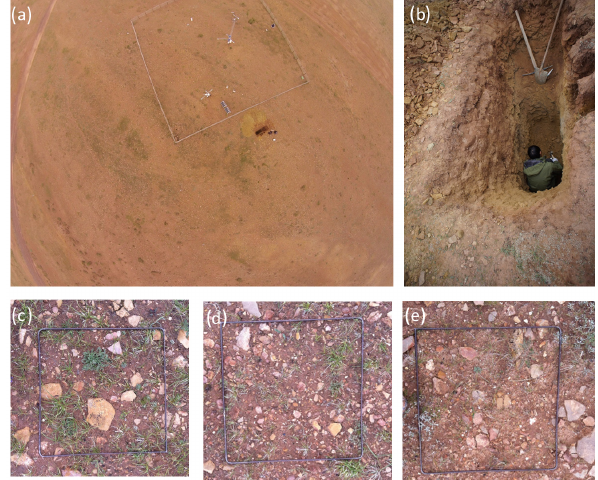
Figure 2. Images of site conditions: (a) the aerial view of the weather station and the excavated soil pit (the borehole is located in the lower-left corner of white fence), (b) the detailed view of the excavated soil pit, and (c–e) examples of vegetation, gravel, and stones (iron frame is about 0.5m × 0.5m).